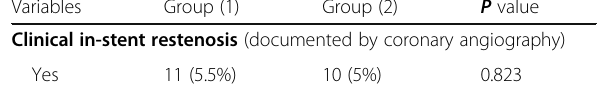
Table 8 Cumulative incidence of clinical in-stent restenosis at 12 months follow up period Variables Group (1) Group (2) P value Clinical in-stent restenosis (documented by coronary angiography)